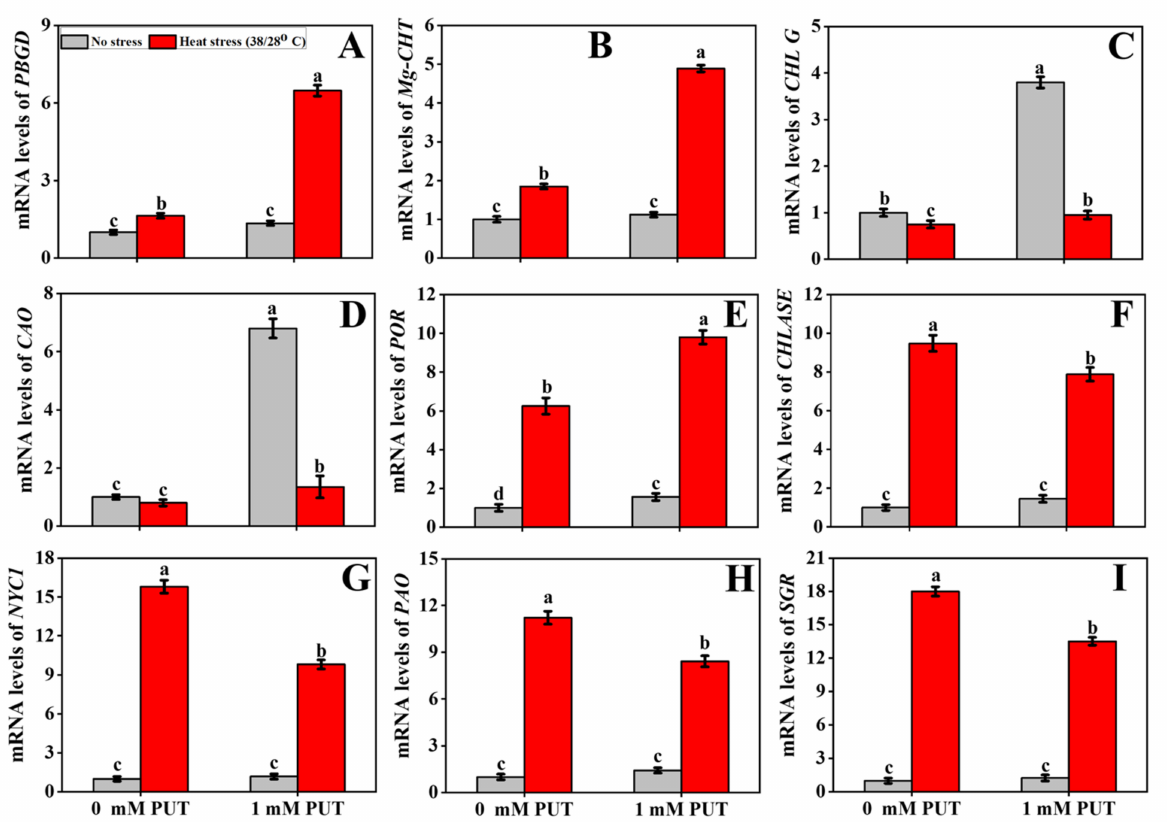
Figure 3. Interactive effects of Putrescine and high temperature on Chlorophyll related genes ex- pression in tomato seedlings. ( A ) Porphobilinogen deaminase ( PBGD ), ( B ) Mg-chelatase ( Mg-CHT ), ( C ) Chl synthase ( CHL G ), ( D ) Chlorophyllide a oxygenase ( CAO ) activity, ( E ) protochlorophyllide oxidoreductase ( POR ), ( F ) Chlorophyllase ( CHLASE ), ( G ) nonyellow coloring ( NYC1 ), ( H ) pheophor- bide a oxidase ( PAO ), and ( I ) stay-green ( SGR ). The data denote the mean value ± standard error (n = 3). Different alphabetic letters represent the significant differences among the treatments at p < 0.05, according to Tukey’s